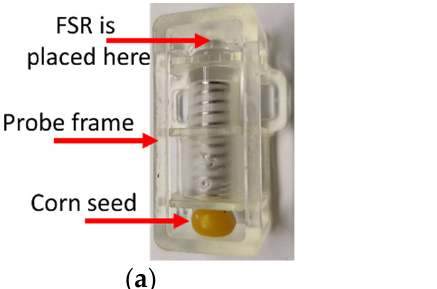
Figure 5. Probe design: ( a ) Complete probe holding corn seed inside it; ( b ) Cylinder containing the spring inside it to protect it from the soil.